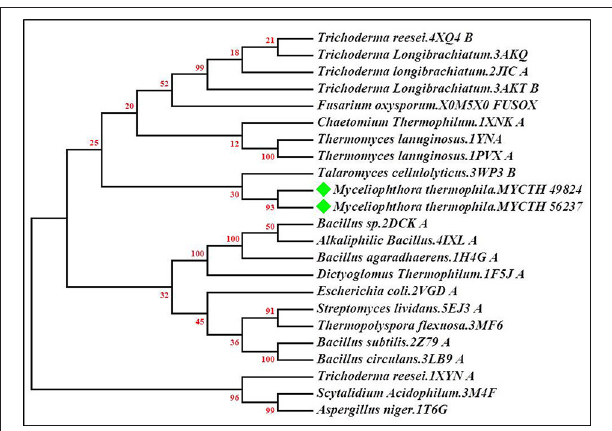
FIGURE 1 | Phylogenetic tree of xylanases ( MYCTH_56237 and MYCTH_49824 ). The tree of selected xylanase sequences was generated by using the neighbor-joining (NJ) method with Poisson model as implemented in Mega software 7.0. MYCTH_56237 and MYCTH_49824 are labeled with green diamonds. PDB numbers of each xylanase are given after each species name. The lengths of the branches show the relative divergence among amino acid sequences of the xylanases and the scale bar indicates the amino acid substitutions per position. Bootstrap values are shown at